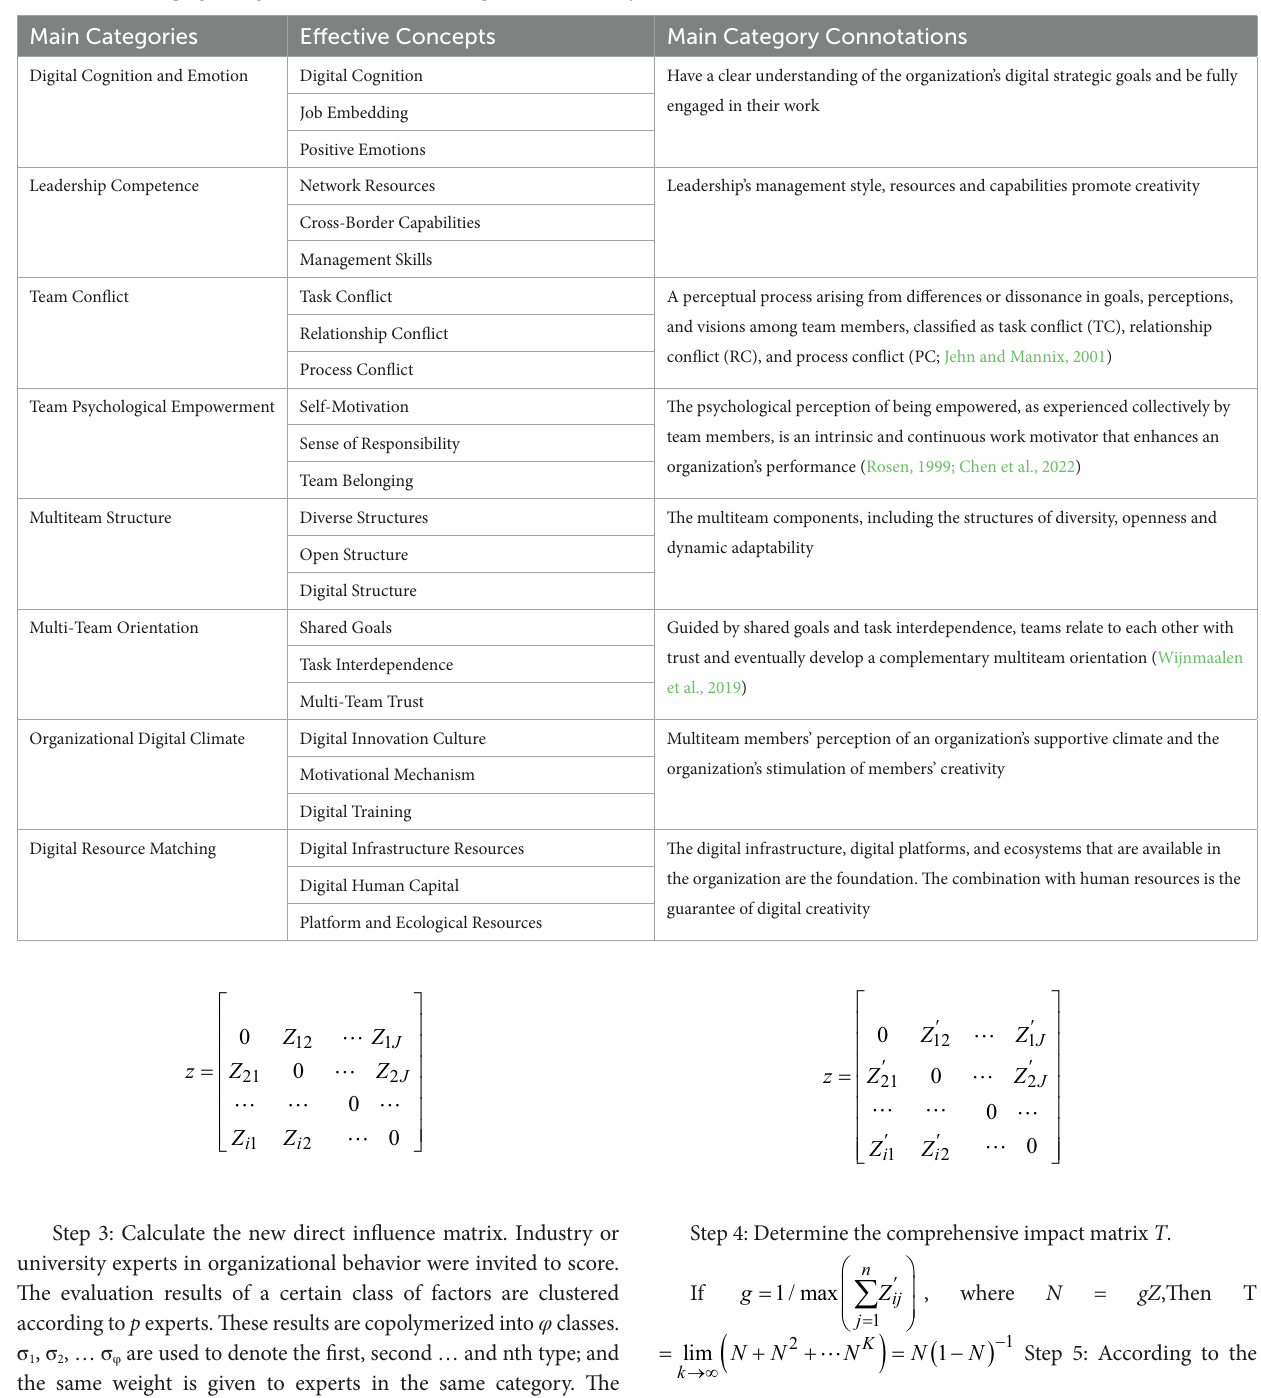
TABLE 3 Main category library of the second-level coding in the transition